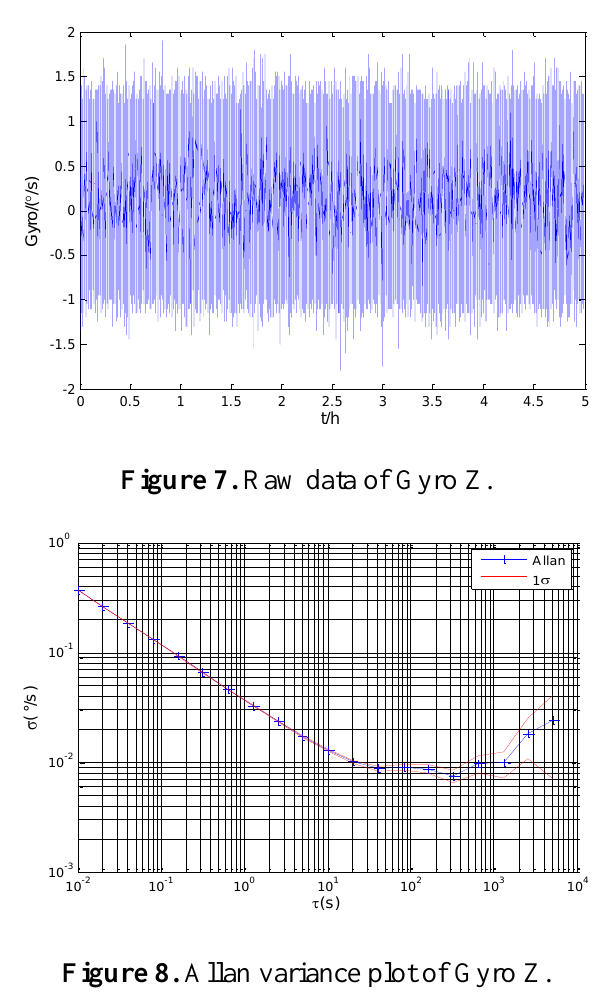
Figure 8. Allan variance plot of Gyro